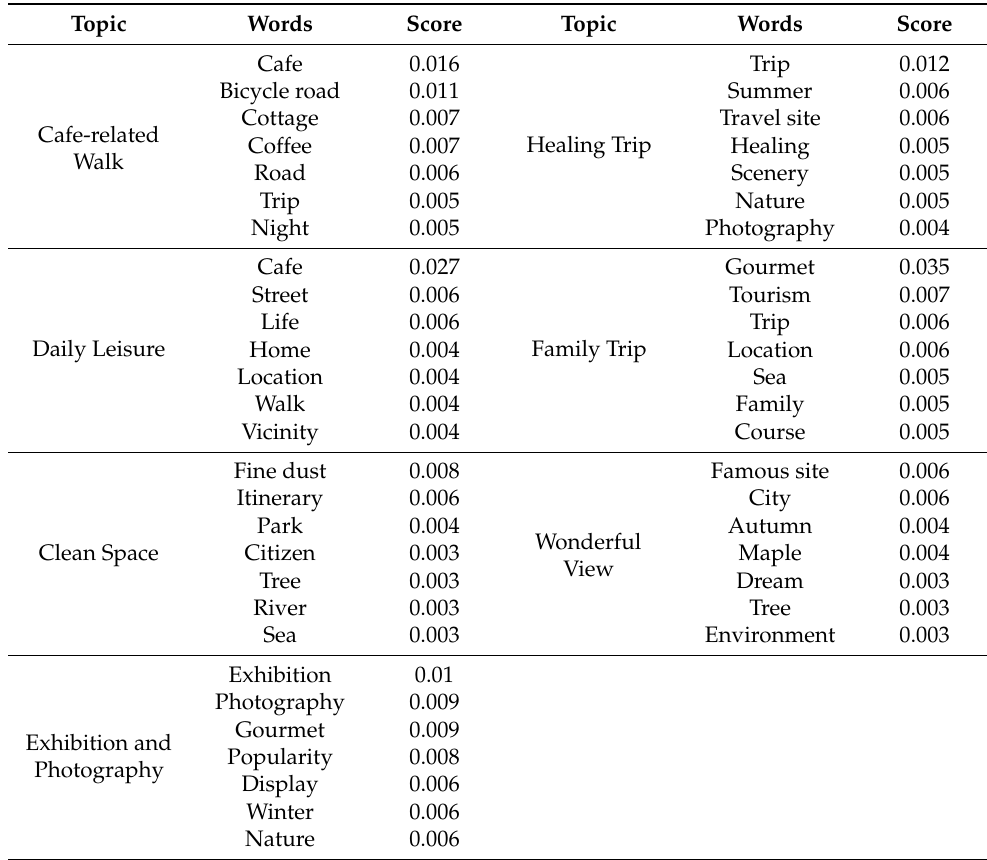
Table 2. Result for LDA Topic-Modeling of Urban